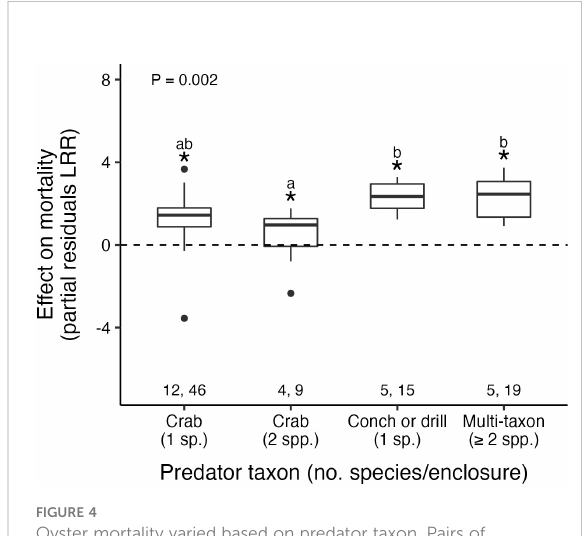
FIGURE 4 Oyster mortality varied based on predator taxon. Pairs of numbers, boxplots, asterisks, letters, and p-value as in Figure 3.